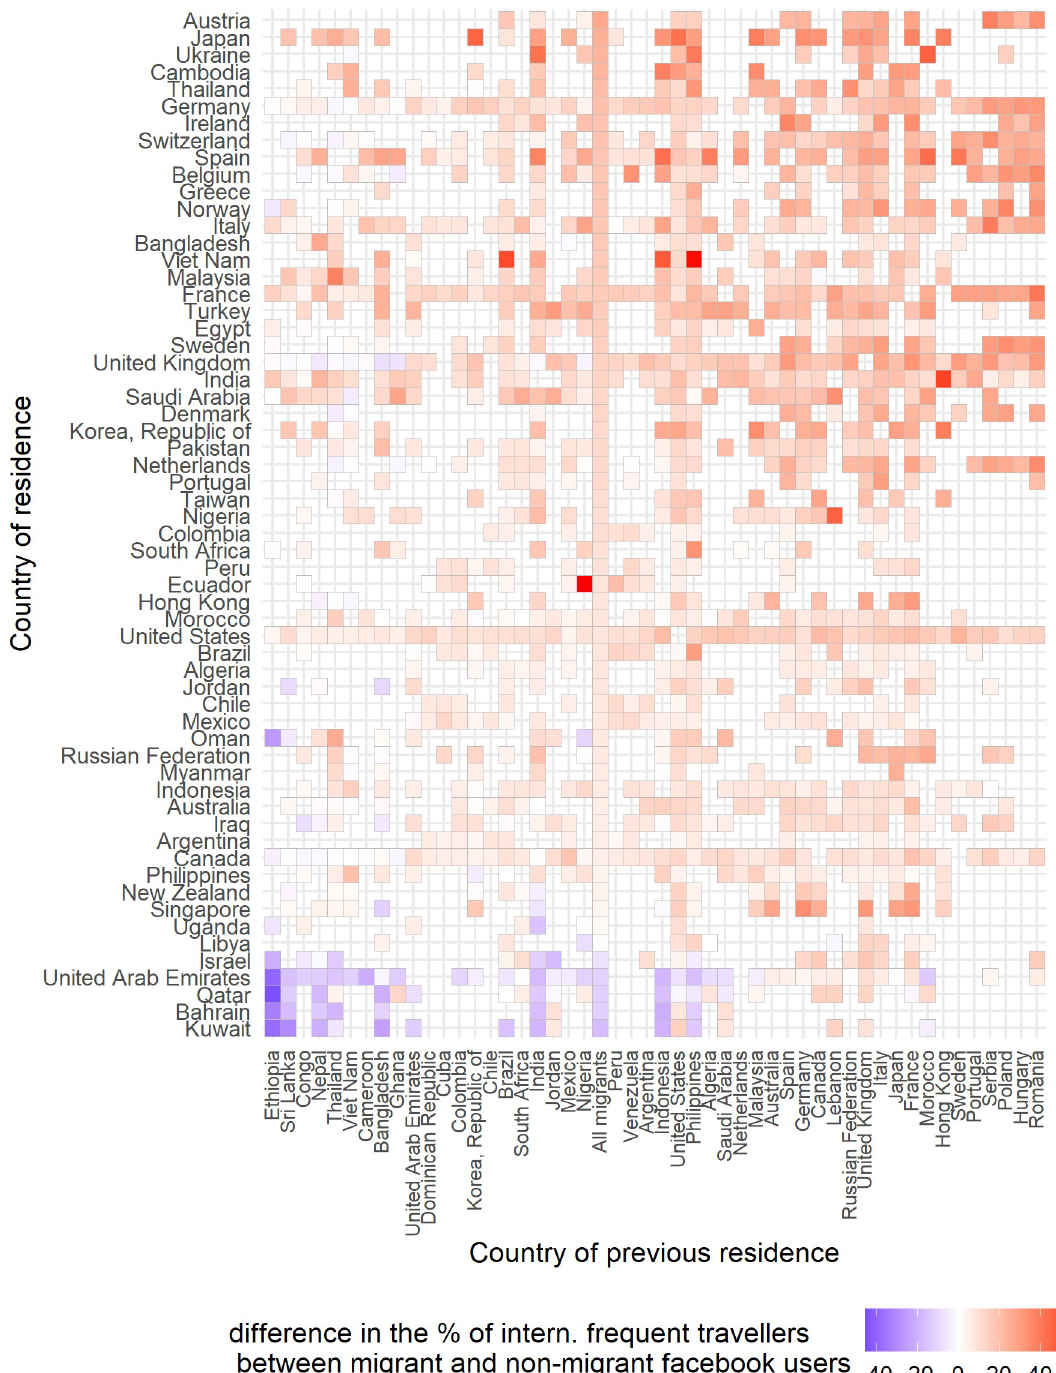
Fig 5. The heatmap of frequent international travellers. The difference in the percentages of frequent international travellers between Facebook migrant users and Facebook non-migrant users of age 15 to 64 for each country of residence. Empty cells mean no available data. The heatmap includes the 60 countries of residence with the highest number of migrant groups and the 50 countries of previous residence with the highest presence in the selected 60 countries of residence.